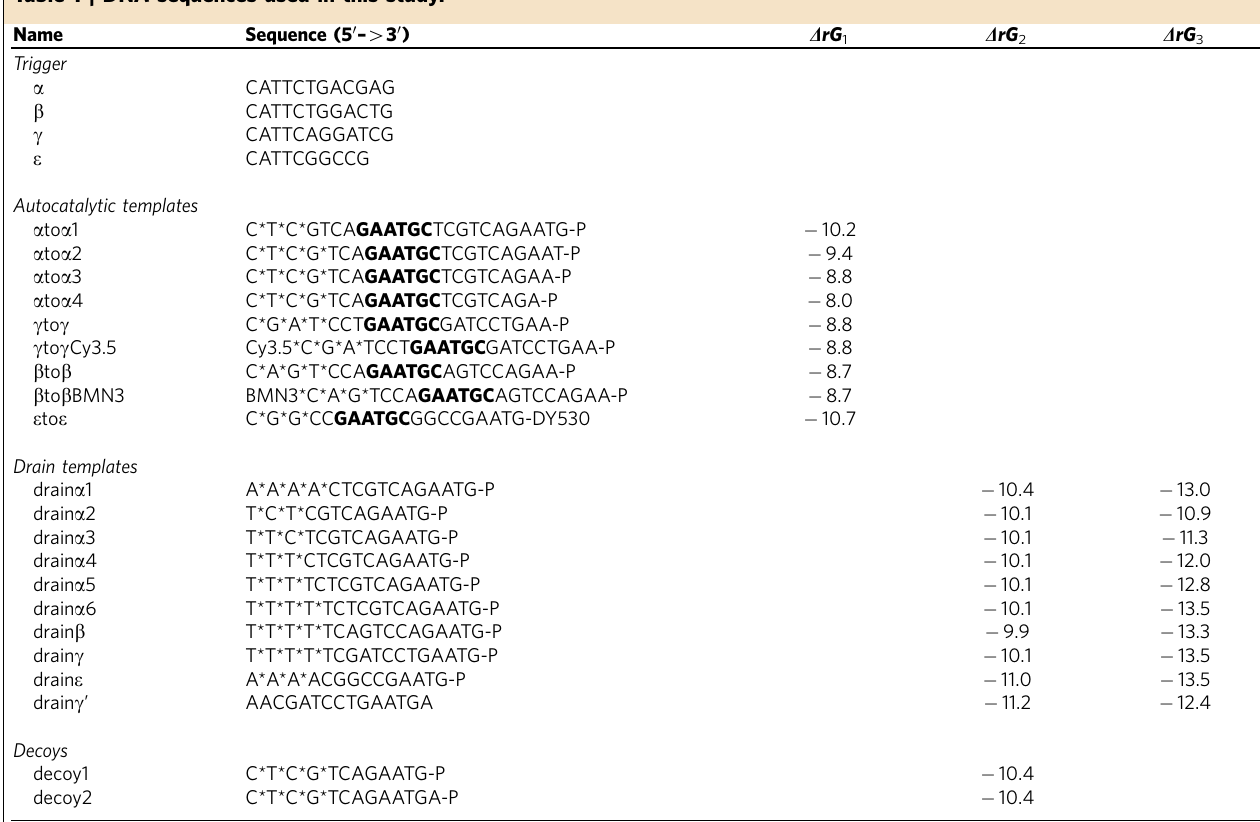
Table 1 | DNA sequences used in this